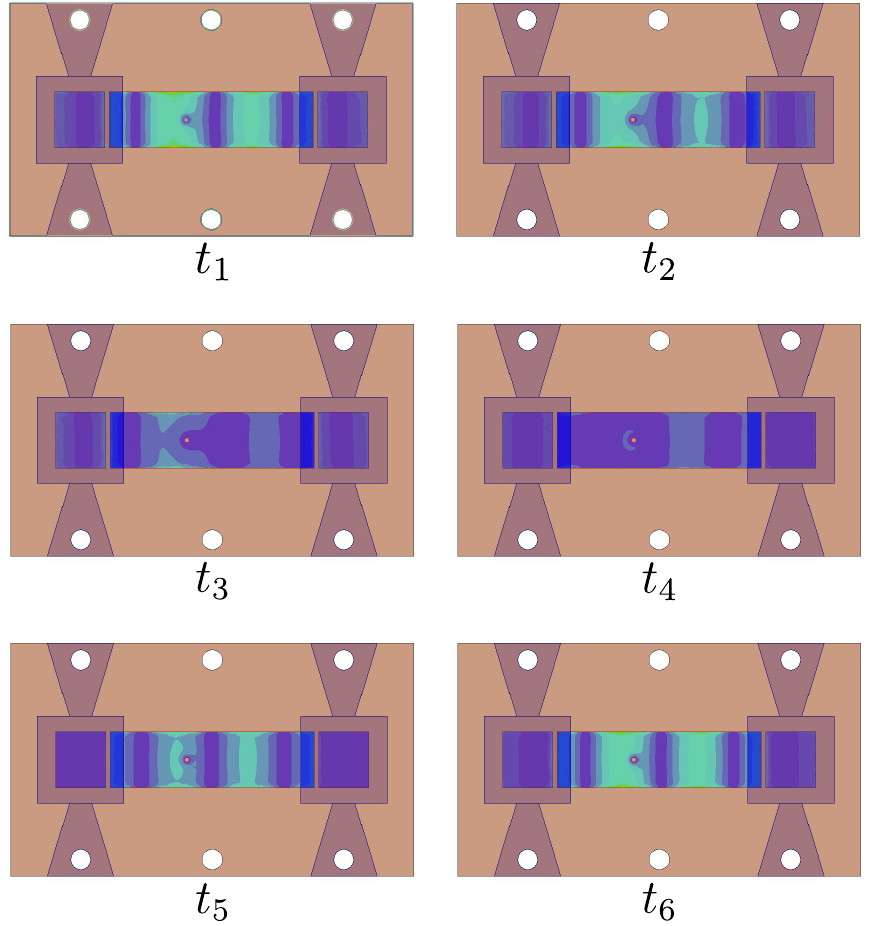
Figure 4. Snapshots of electric field distribution in proposed array demonstrating standing-wave excitation in the feed